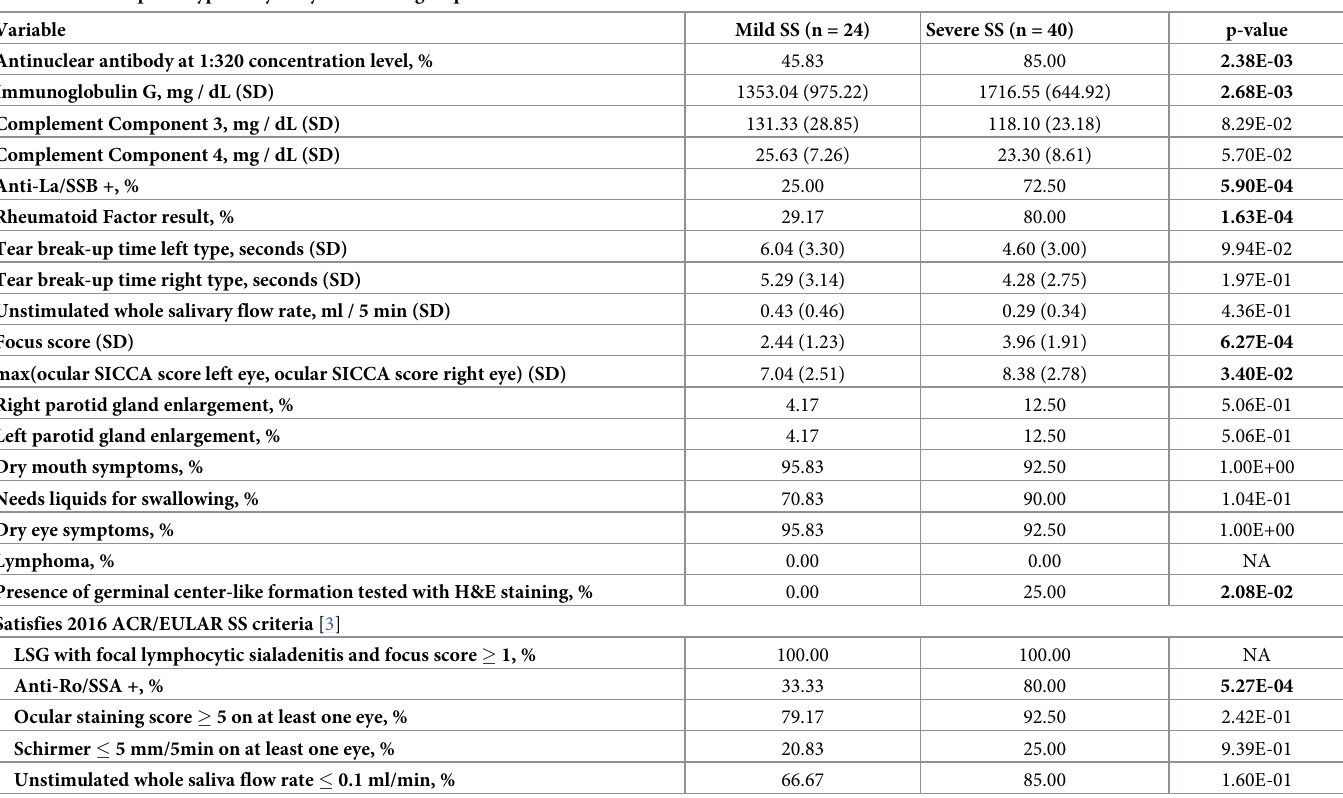
Table 2. Clinical phenotype analysis by disease subgroup.